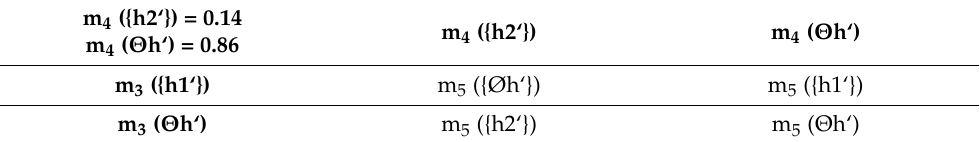
Table 7. Intermediate hypothesis